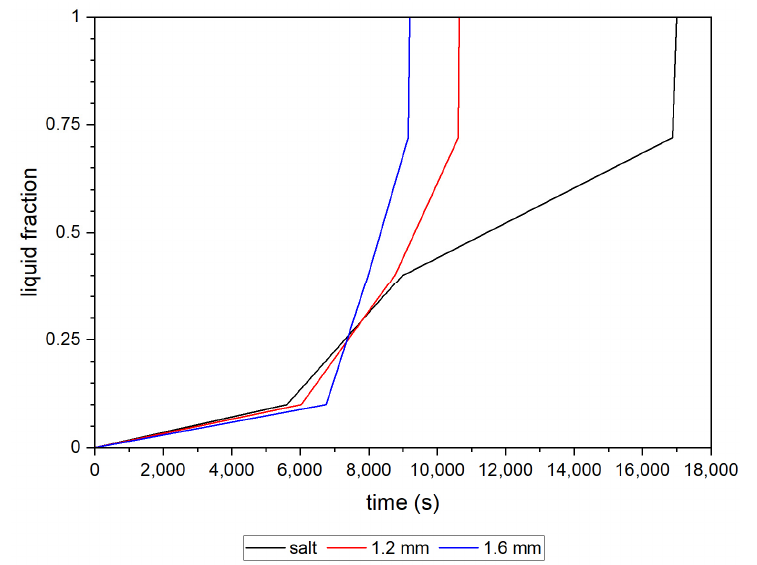
Figure 8. Liquid phase formation estimated on the basis of the excess temperature of the phase transition at the measuring points.